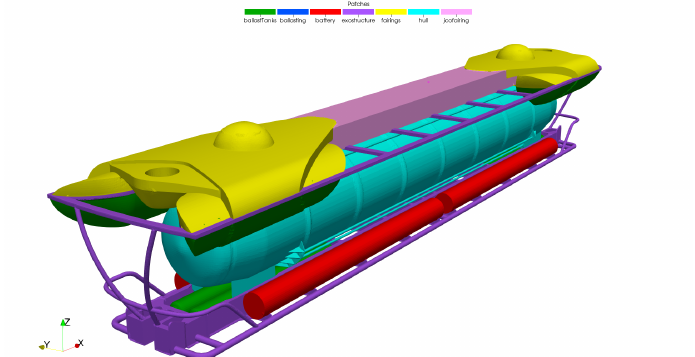
Figure 4. Geometry 3: Geometry of the pressure hull and exostructure used in the CFD simulation. The geometry is divided into a number of different patches denoted on the